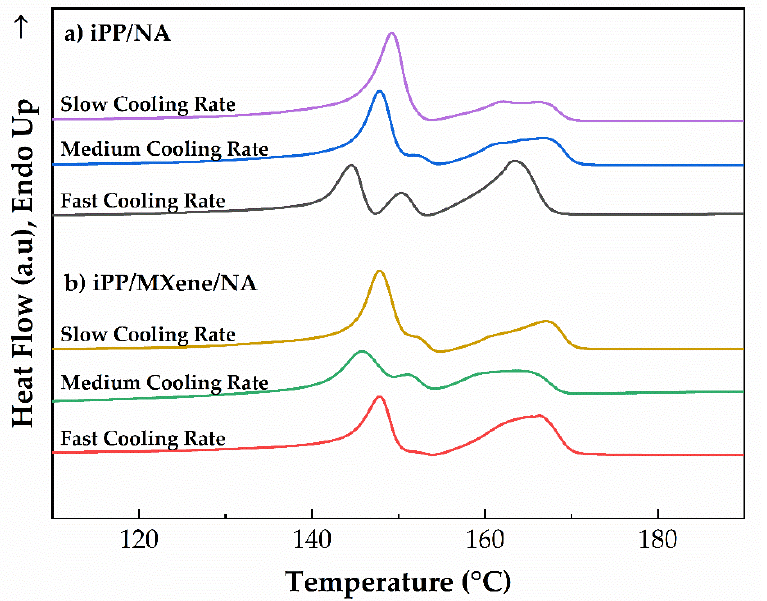
Figure 13. DSC melting curves of ( a ) iPP/ β -NA and ( b ) iPP/MXene/ β -NA of different thermal histories.